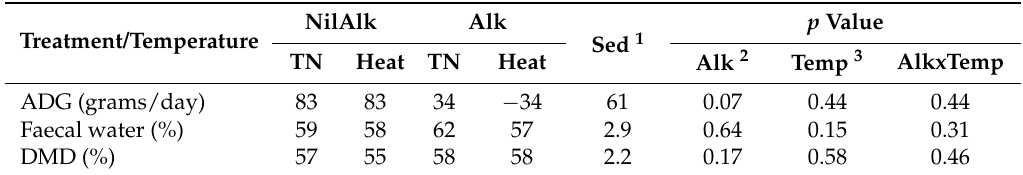
Table 1. Overall average daily gain (ADG), faecal water (%) and dry matter digestibility (DMD) for each treatment.